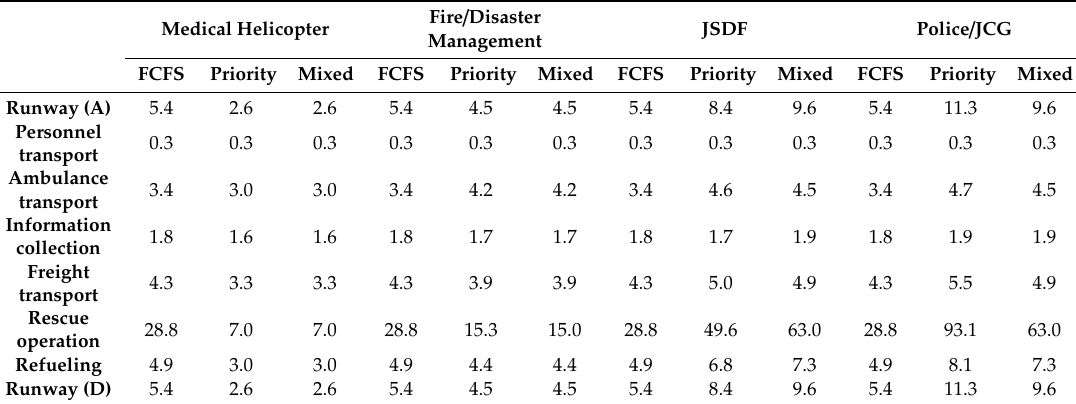
Table 7. Aircraft waiting times in queue after a disaster, with application of di ff erent queuing disciplines (unit: